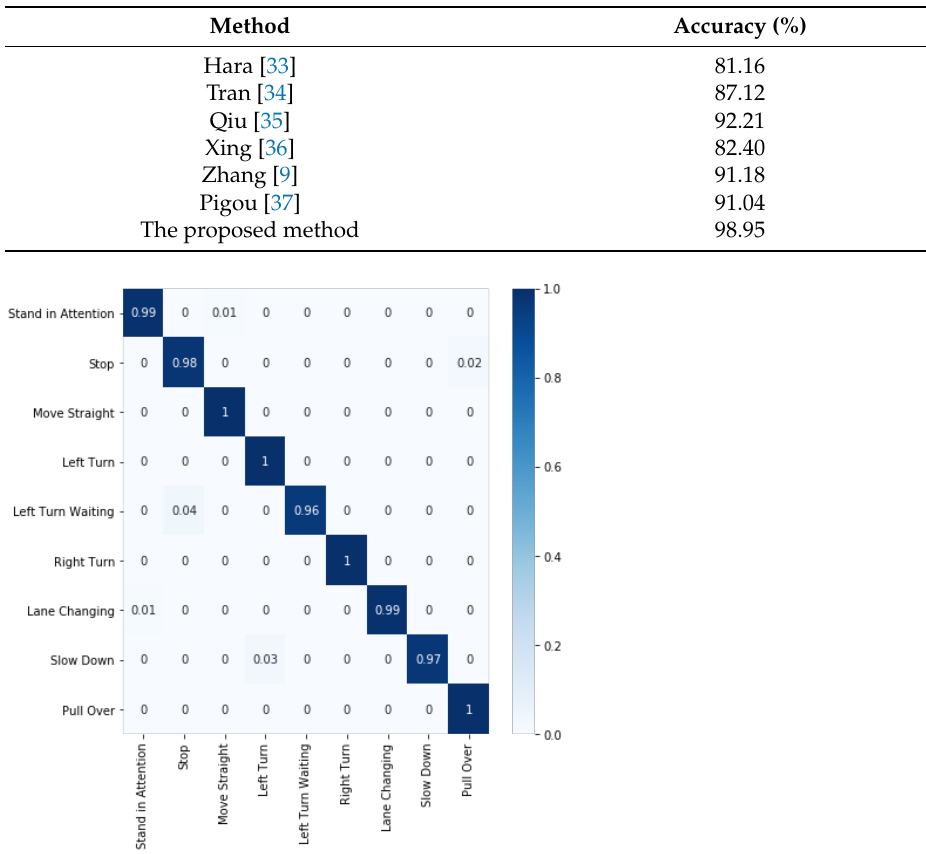
Table 3. The accuracy comparison with some typical network architectures on the Chinese Traffic Police Gesture Dataset.